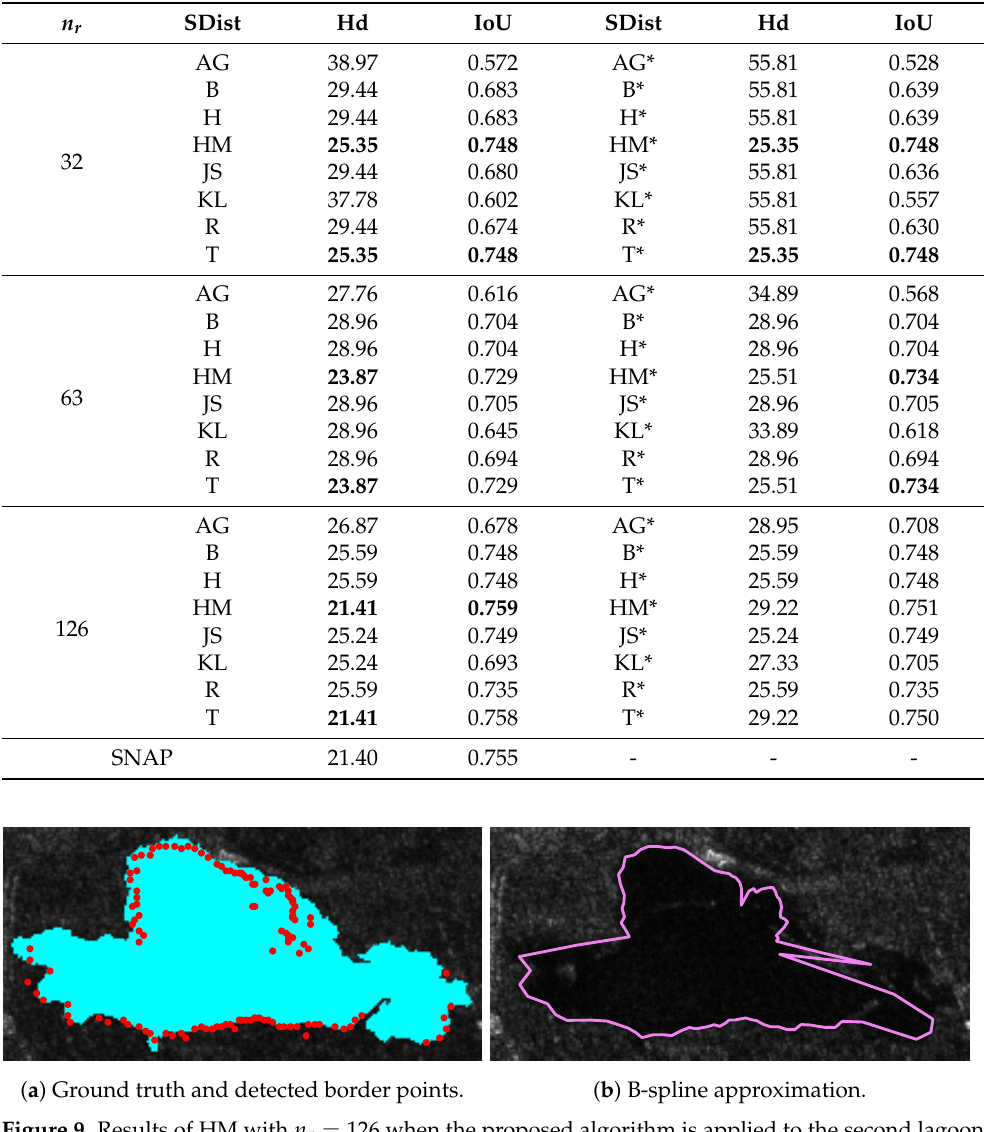
Table 7. Quality measure results for the image in Figure 3 middle left, for each stochastic distance (SDist).